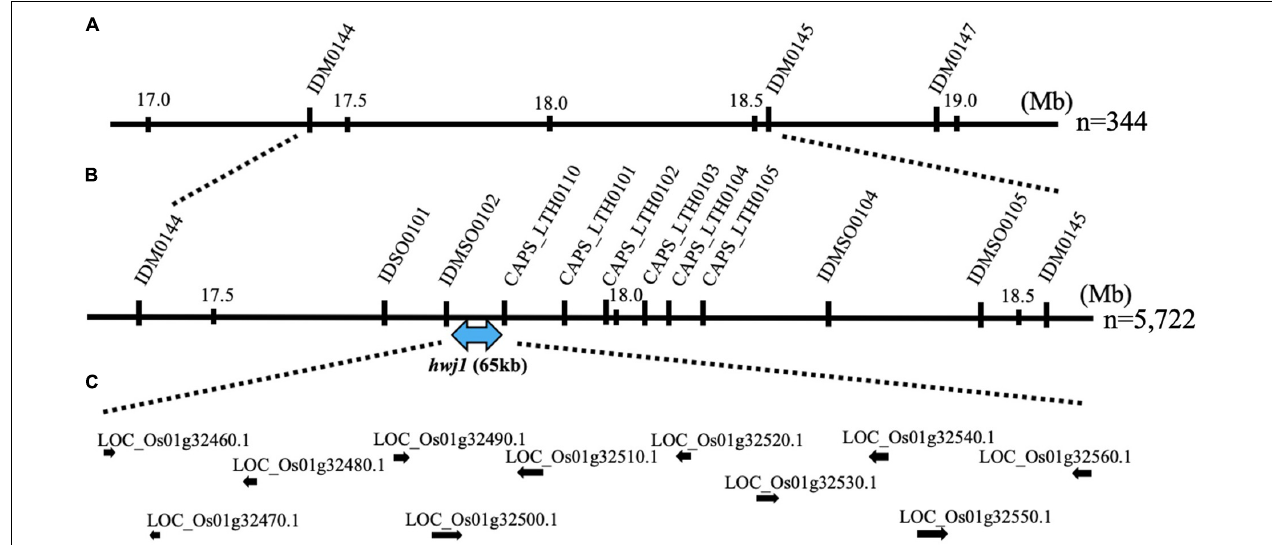
FIGURE 5 | Fine mapping of the hwj1 locus. (A) Initial mapping of hwj1 on chromosome 1. Numbers show physical positions in megabase (Mb), (B) fine mapping of hwj1 . The hwj1 locus was delimited between flanking markers IDMSO0102 and CAPS_LTH0110. Blue-double head arrow shows candidate region, and (C) annotated genes in the candidate region. The black arrows represent the annotated genes.